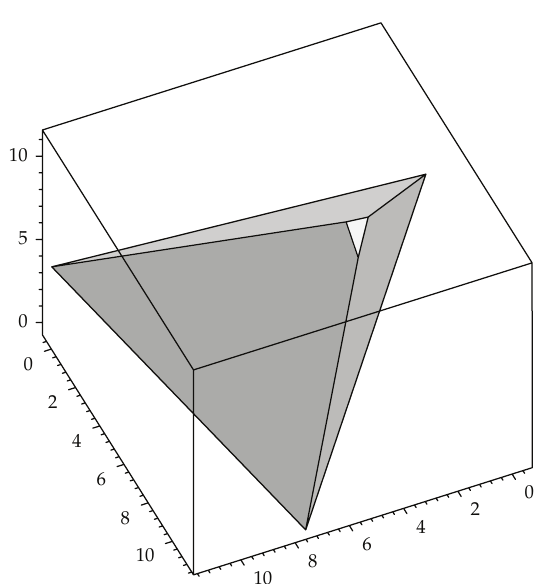
Figure 2: An example of the polytope T 4 in the case r (cid:7) 4. The vertices are in (cid:4) − 1 / 2 ,r − 1 / 2 , 2 r − 1 / 2 (cid:5) , (cid:4) r − 2 / 3 , 2 r − 2 / 3 , 3 r − 2 / 3 (cid:5) , (cid:4) r, 2 r − 1 , 3 r − 1 (cid:5) , (cid:4) r, 2 r, 3 r − 2 (cid:5) , (cid:4) 2 r − 1 / 2 , 3 r − 1 / 2 , − 1 / 2 (cid:5) , and (cid:4) 3 r − 1 / 2 , − 1 / 2 ,r − 1 / 2 (cid:5) .